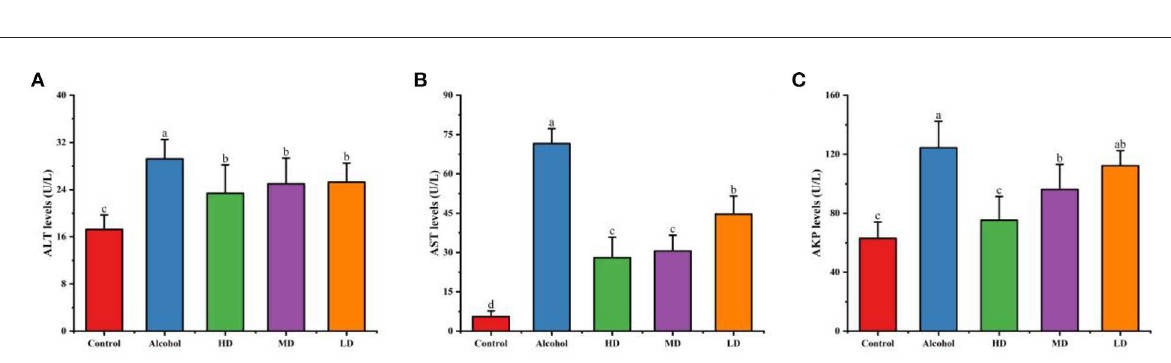
root extract activated ALDH, indicating that lotus root extract could accelerate the metabolism of ethanol and acetaldehyde in mice and reduce the damage caused by acute alcohol